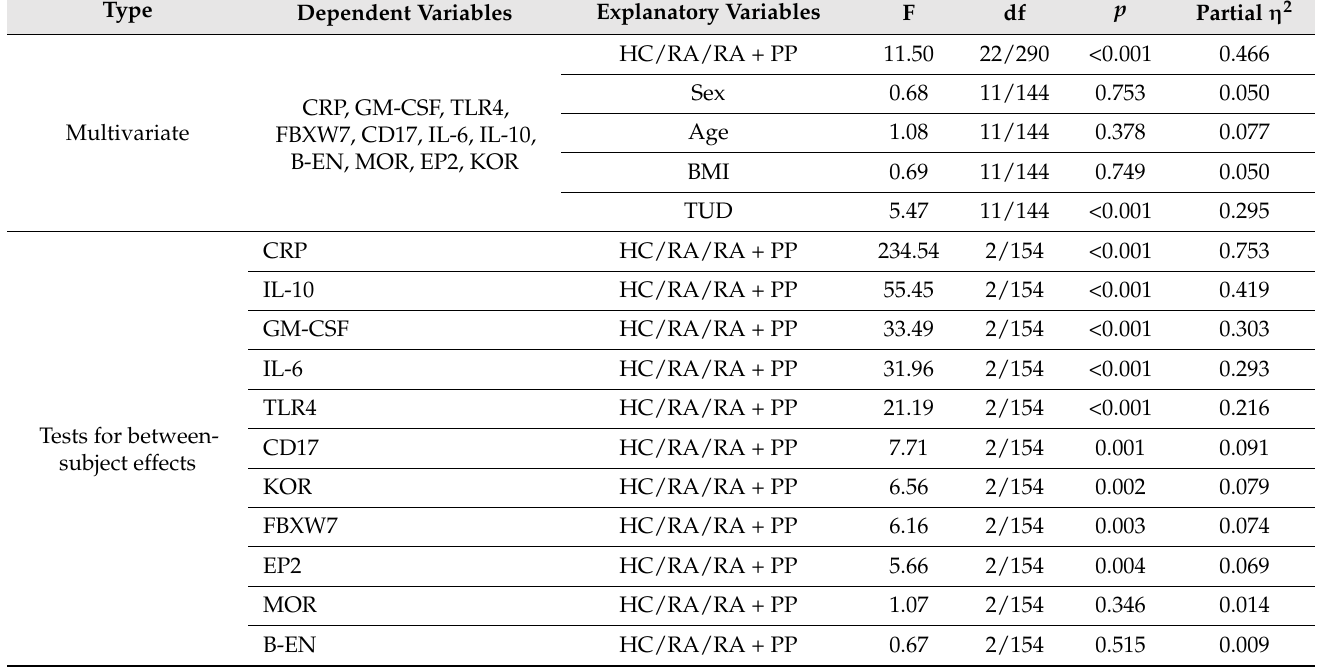
Table 2. Results of multivariate GLM analysis showing the associations between biomarkers and diagnosis while adjusting for background variables.